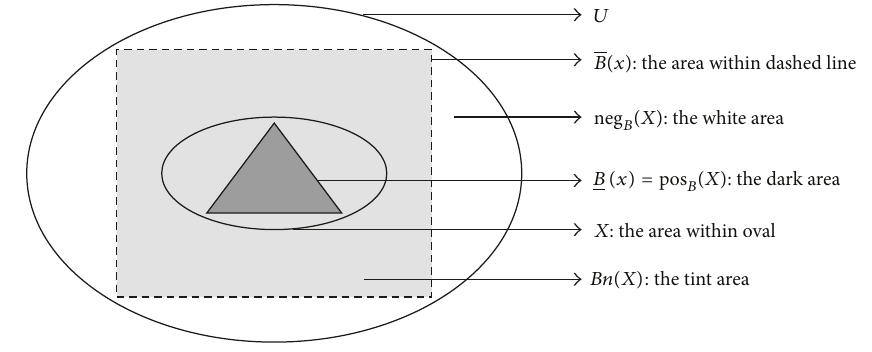
Figure 1: Diagram of approximation